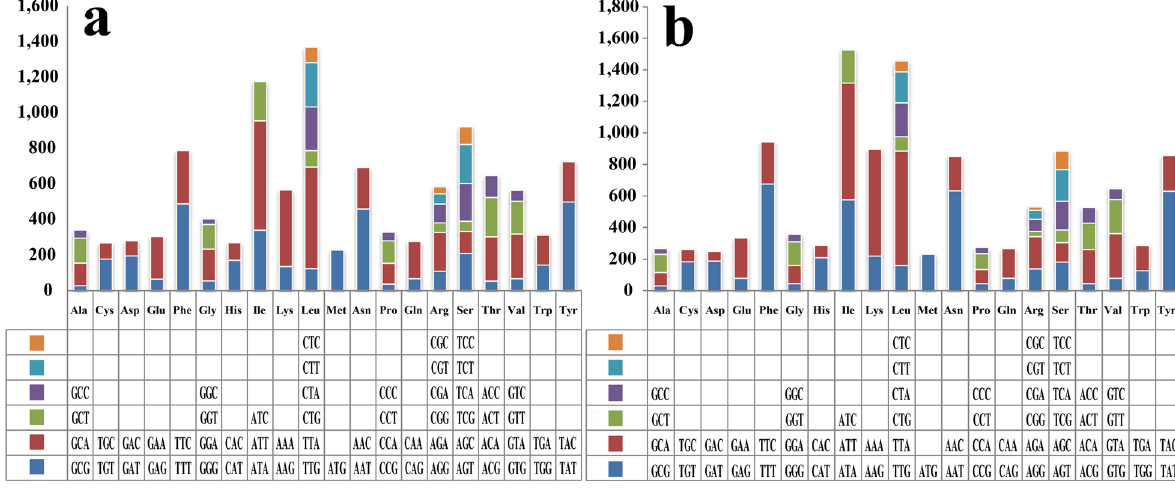
Fig. 4 Codon usage in the mitogenomes of two Apiotrichum species. Frequency of codon usage is plotted on the y-axis. a Apiotrichum gracile ; b Apiotrichum